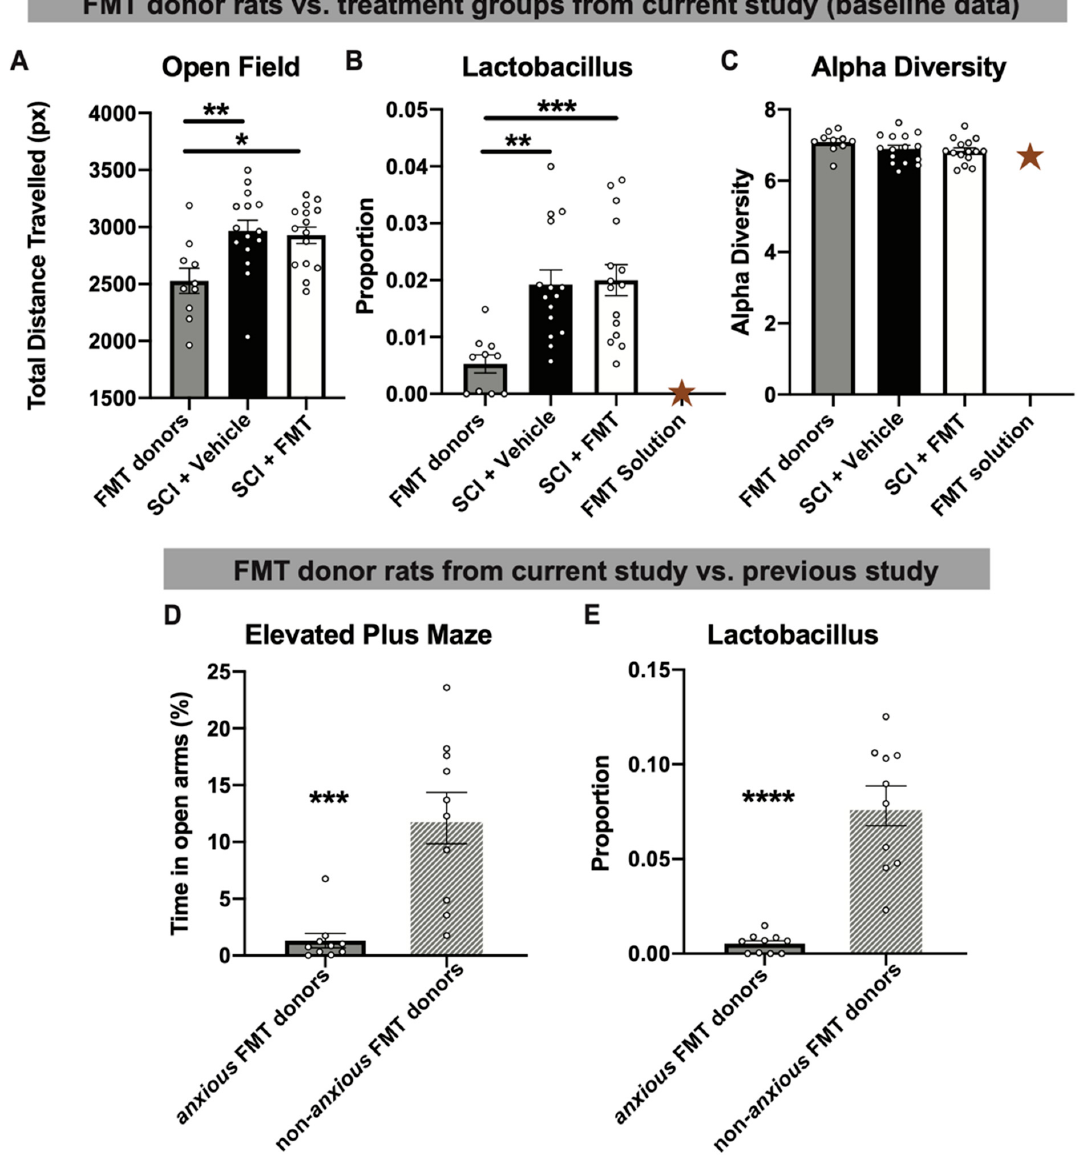
Figure 2. Uninjured FMT donor rats displayed altered baseline levels of anxiety-like behaviour and proportions of fecal Lactobacillus . ( A ) Fecal microbiota transplant (FMT) donors travelled significantly less distance in the open field compared to the SCI + vehicle and SCI + FMT treatment groups in the present experiment (measured at baseline prior to SCI). ( B ) Fecal matter from FMT donors had significantly decreased baseline proportions of Lactobacillus , which is also reflected in the decreased amount of Lactobacillus found in the FMT solution. ( C ) All groups had similar baseline levels of alpha diversity, including the FMT solution. ( D ) FMT donors in the current study displayed significantly increased anxiety-like behaviour in the elevated plus maze (indicated by the percent of time spent in the open arms) and ( E ) had significantly less fecal proportion of Lactobacillus relative to successful FMT donor rats from previous experiments. * p < 0.05, ** p < 0.01, *** p < 0.001, **** p < 0.0001. Gold star represents the FMT solution (A single value and therefore not included in statistical analysis). Error bars represent standard error mean.